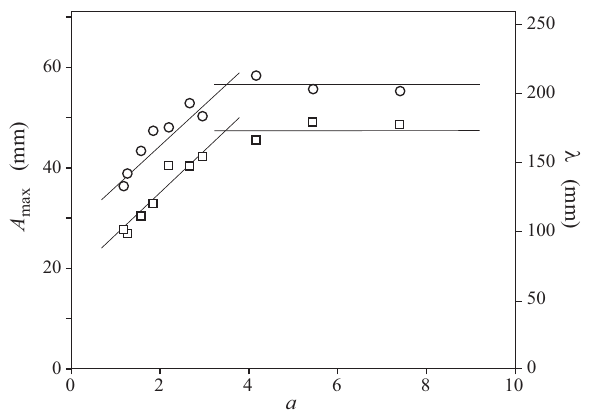
Figure 6. ( ◦ ) Maximum amplitude A max and ( (cid:3) ) mid-height width λ of the leading wave as a function of the aspect ratio a of an initial column of mass M = 6 . 5 kg and of grain diam- eters d = 5 mm. All the data correspond to breaking waves. (—) Guidelines for the